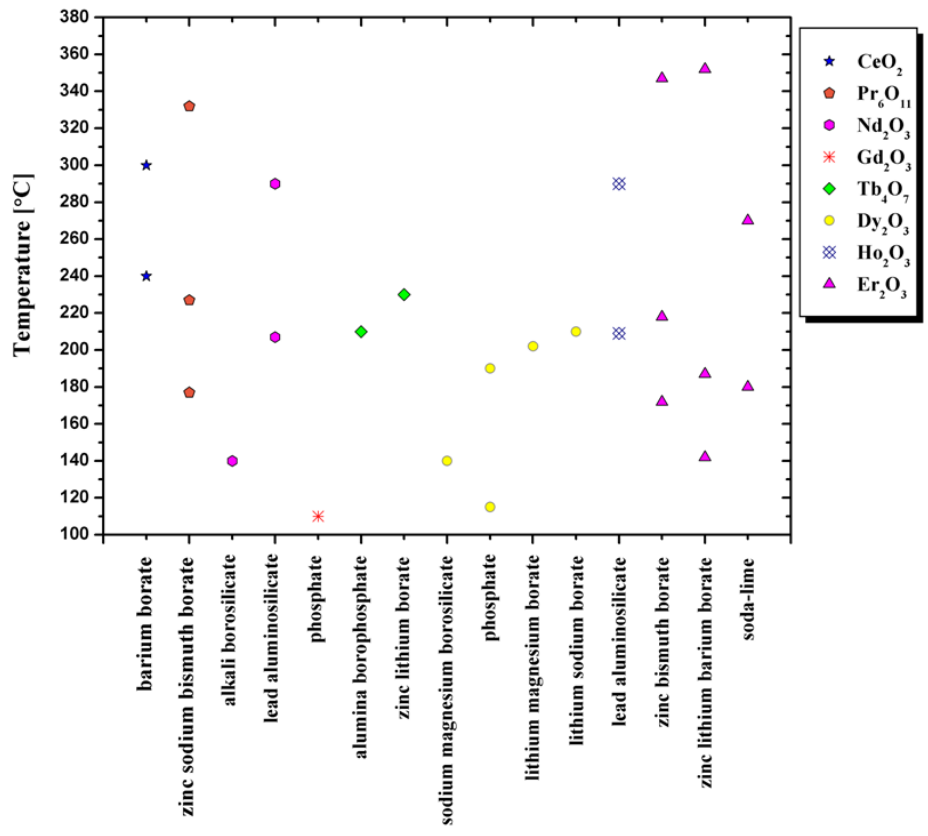
Figure 4. The juxtaposition of the temperatures for the thermoluminescence peak maxima based on various glass systems data [48,114 – 123,134,140,141].